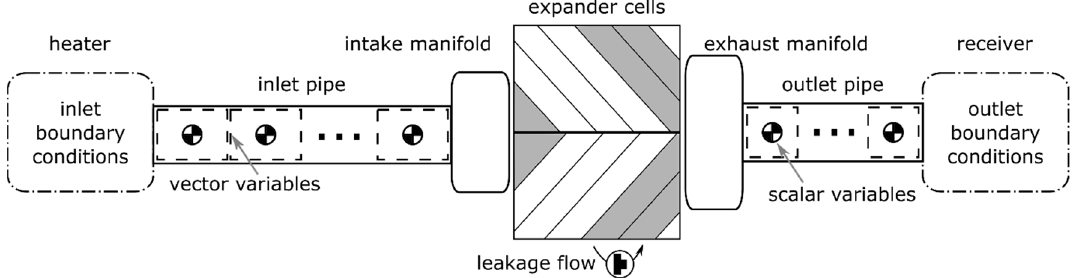
Figure 3. Modelling scheme for a twin-screw machine.